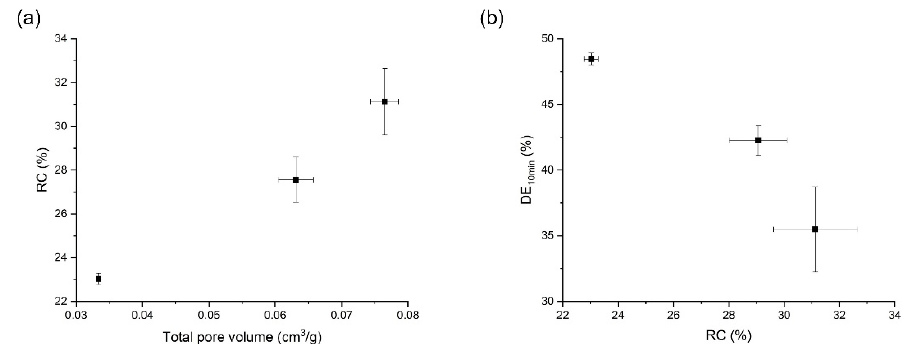
Figure 9. ( a ) Correlation between total pore volume and RC and ( b ) correlation between RC and DE 10 for orlistat-loaded Neusilin ® UFL2 samples prepared by MA-SCF at various temperature, with a constant pressure of 10 MPa.